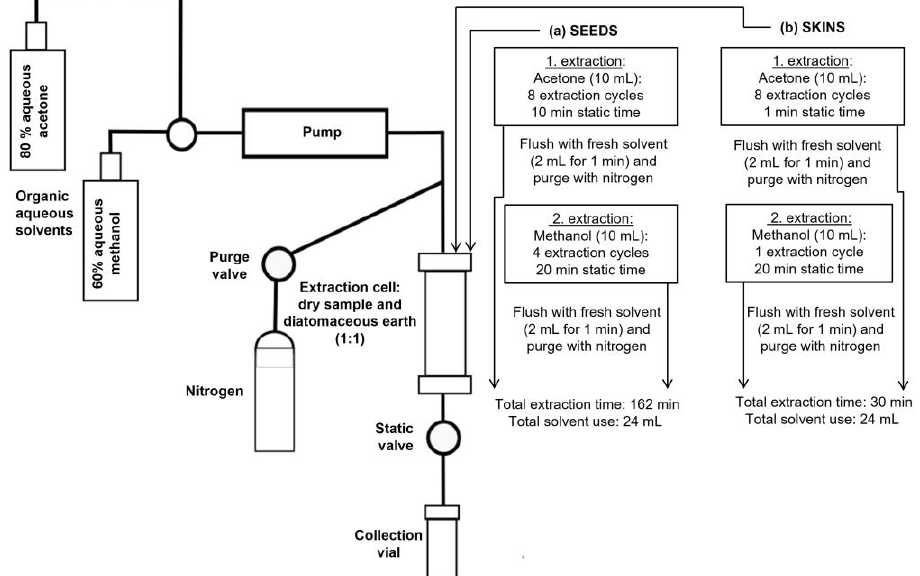
Figure 3. Schematic outline of proposed accelerated solvent extraction at room temperature and 10.3 MPa for extraction of phenols from ( a ) lyophilised grape seed powder and ( b ) lyophilised grape skin powder. Acetone − 80% aqueous acetone; Methanol − 60% aqueous methanol.